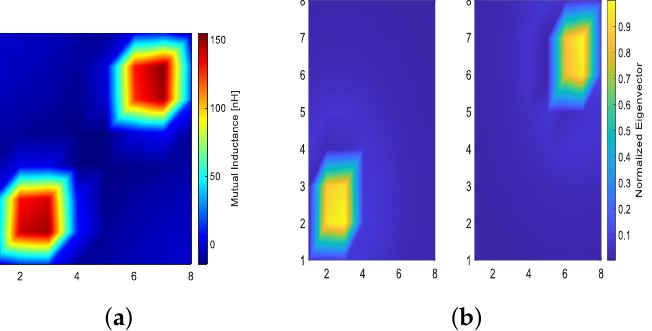
Figure 4. Comparison result of eigenvector and mutual inductance distribution for case 6. ( a ) Mutual inductance distribution with two Rx coils. ( b ) Normalized eigenvector distribution of H H R R H ( Rx 1 ) ( left ), and H H R R H ( Rx 2 ) ( right